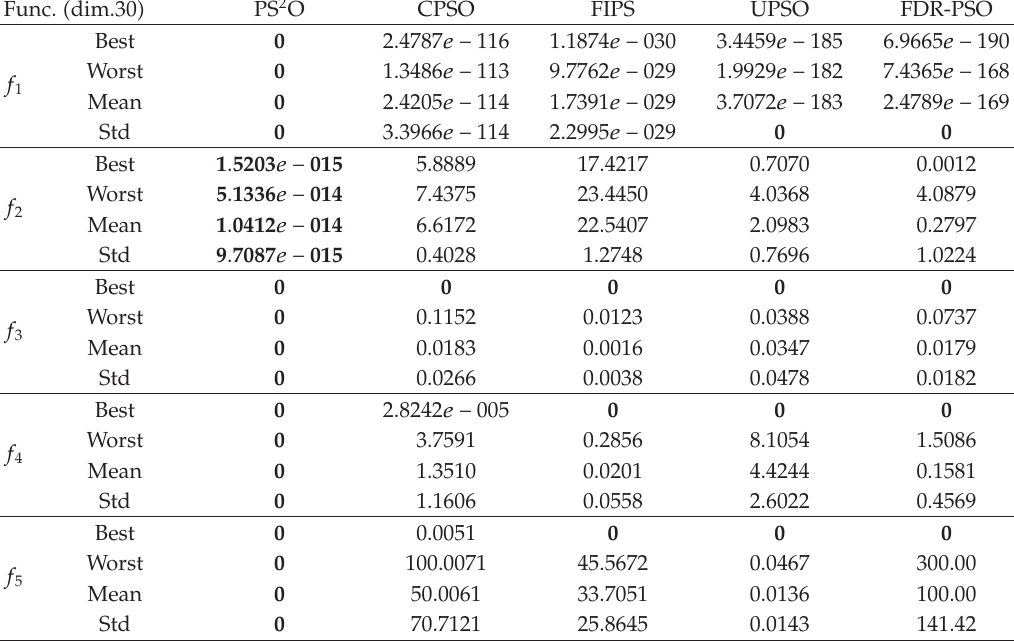
Table 3: Performance of all algorithms. In bold are the best